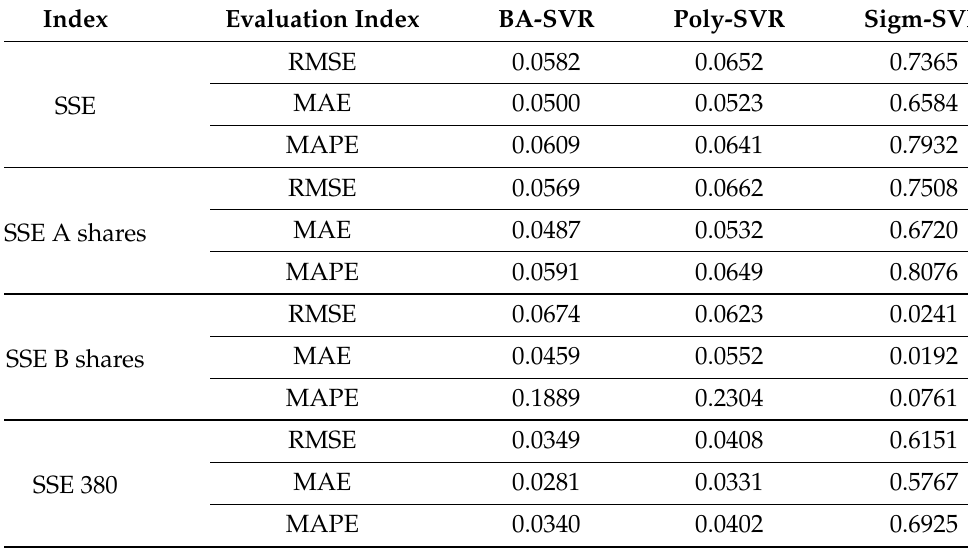
Table 9. The 60-day mid-term forecast effect of 18 stock